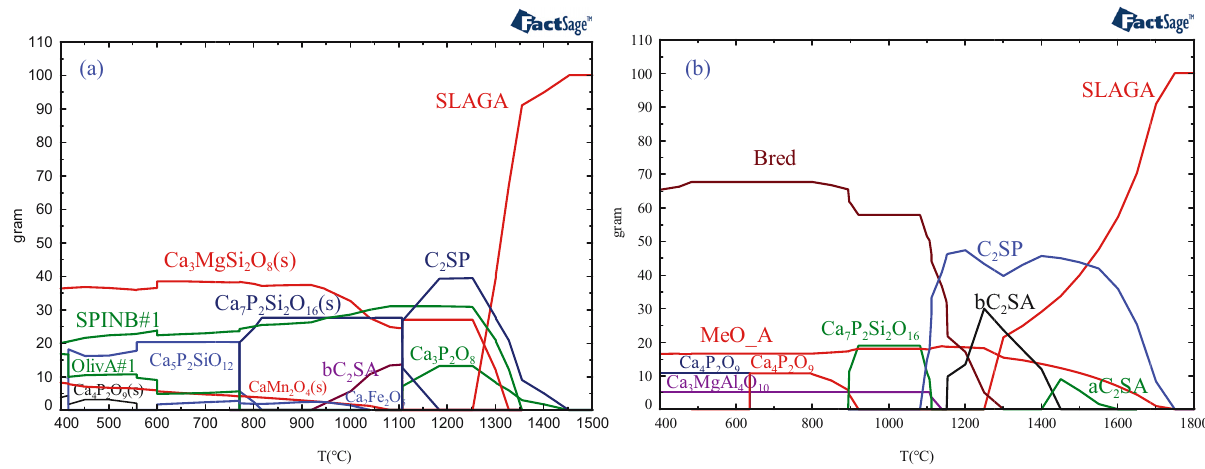
Figure 10: Main phases and precipitation behavior of the slag C before and after the experiment: ( a ) R = 2.0 ( initial slag ) , ( b ) R = 2.0 ( fi nal slag )